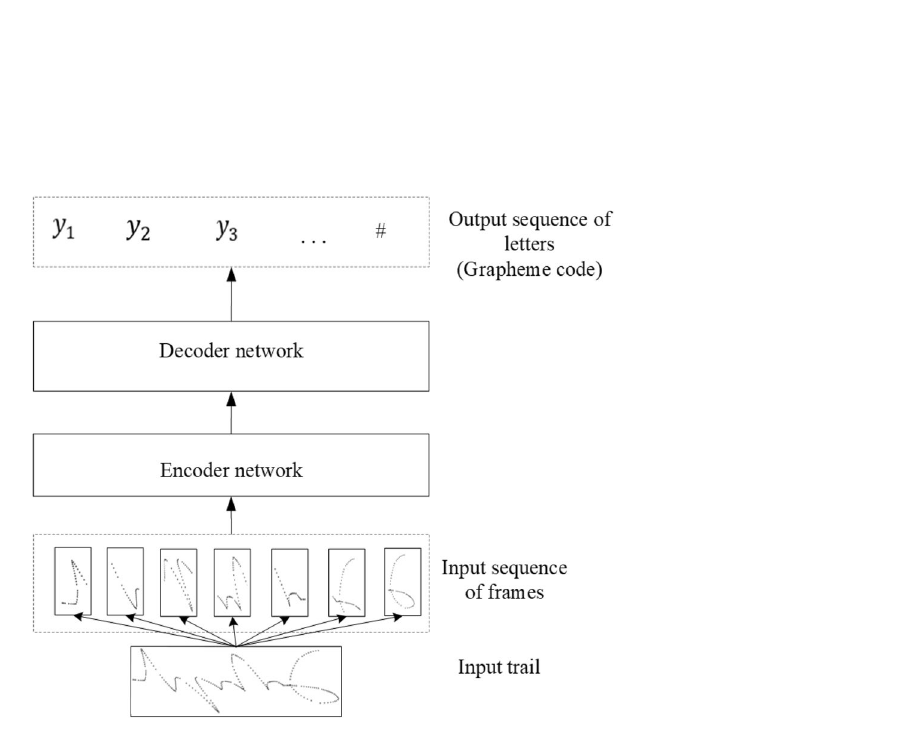
Figure 13. Architecture of the encoder–decoder